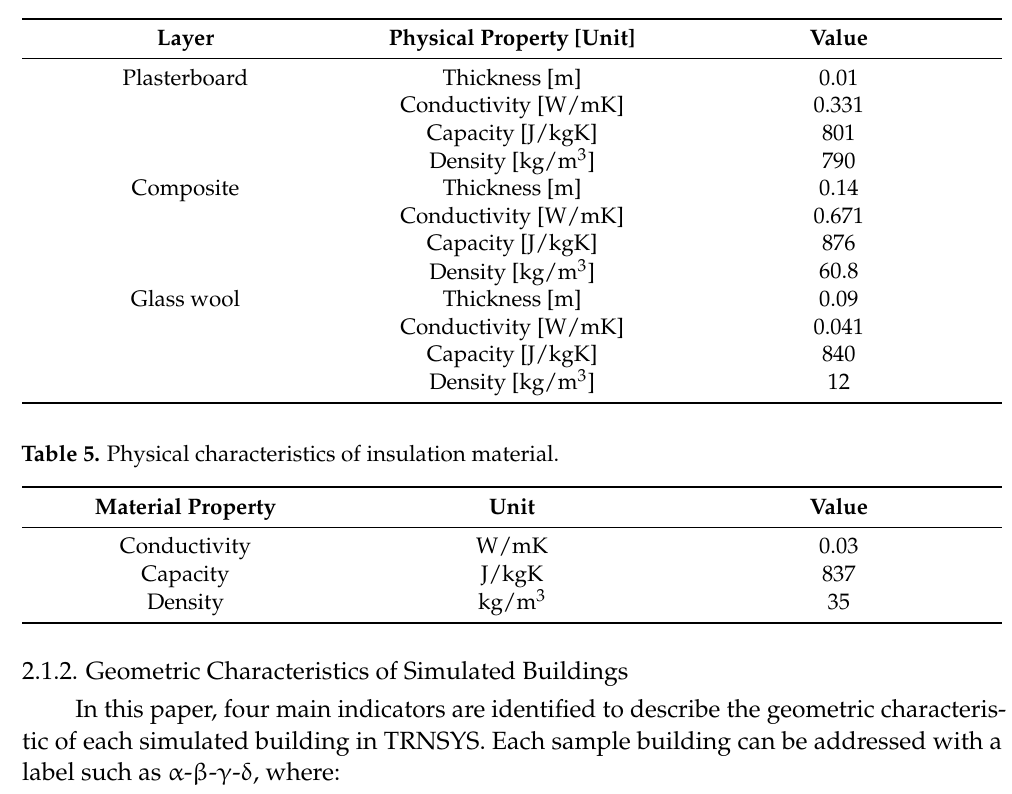
Table 4. Thermal properties of a light-structured wall.